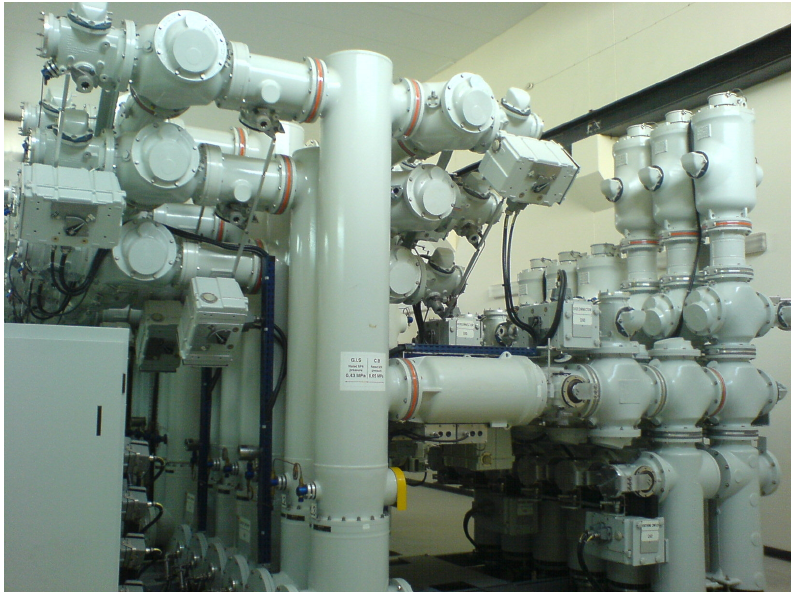
Figure 8. Gas insulated